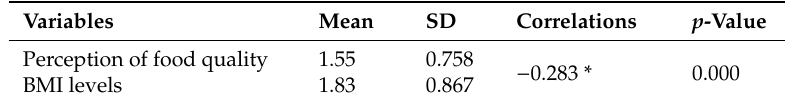
Table 11. Correlation analysis between BMI levels and reproductive-age women’s perception of food